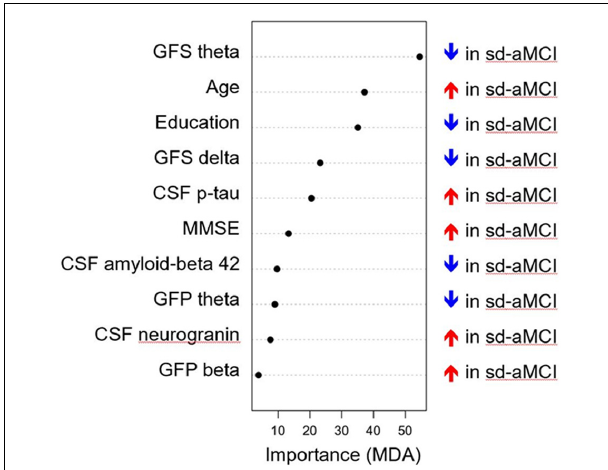
FIGURE 1 | Classification model for differentiating sd-aMCI and md-aMCI. The x -axis displays the importance of the variables in the differentiation between sd-aMCI and md-aMCI, with higher values (i.e., dots to the right side) indicating a greater importance. MDA, mean decrease accuracy; GFP, global field power; GFS, global field synchronization; MMSE, Mini-Mental State Examination; MCI, mild cognitive impairment; md-aMCI, multidomain amnestic MCI; sd-aMCI, single domain amnestic MCI.